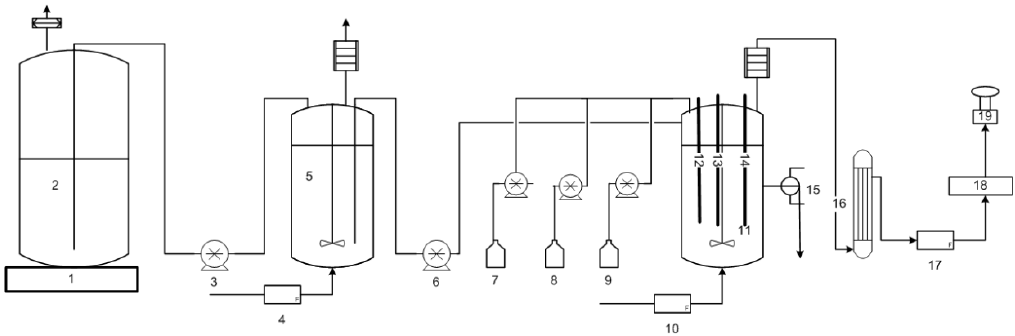
Figure 2. Continuous fermentation equipment. 1, stir plate; 2, Feed Carboy; 3, feed transfer pump; 4,